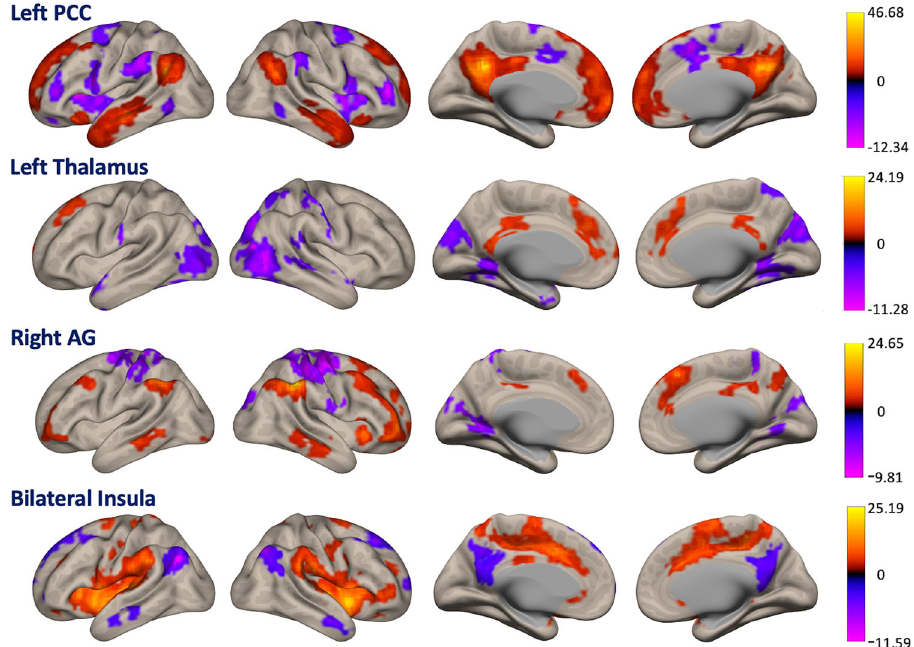
Fig. 4 Functional connectivity networks associated with the posterior cingulate cortex, thalamus, right angular gyrus, and bilateral insula. In a seed correlation analysis, those regions that showed intrinsic connectivity contrast (ICC) modi fi cations were used as seed areas to evaluate the ensuing brain networks. The posterior cingulate cortex and insula are associated with established default mode network and salience network regions, respectively. Color bars represent the t -values for the one-sample t -test. A statistical uncorrected voxel-level threshold of p < 0.001 at the whole-brain level was applied, with a subsequent cluster-level threshold of p < 0.05 family-wise error corrected ( n = 11).